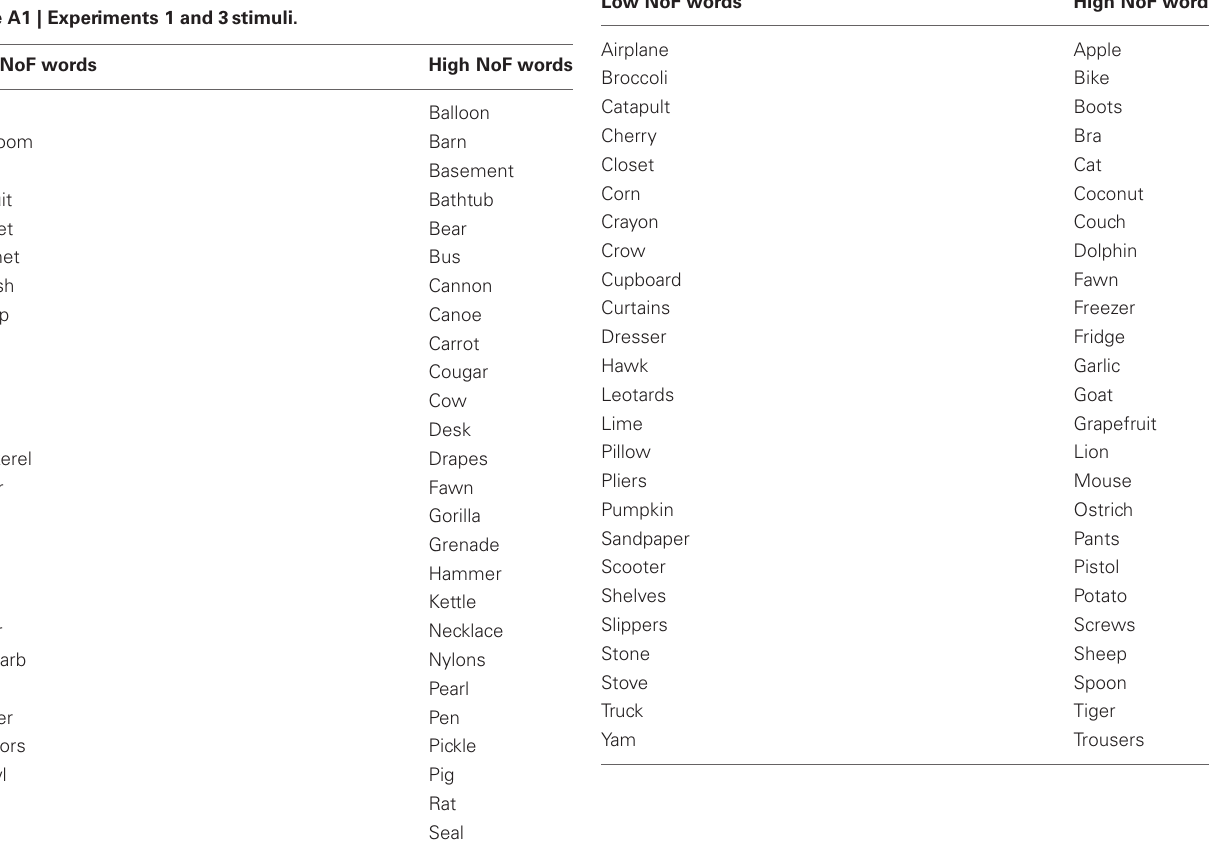
Table A1 | Experiments 1 and 3stimuli.